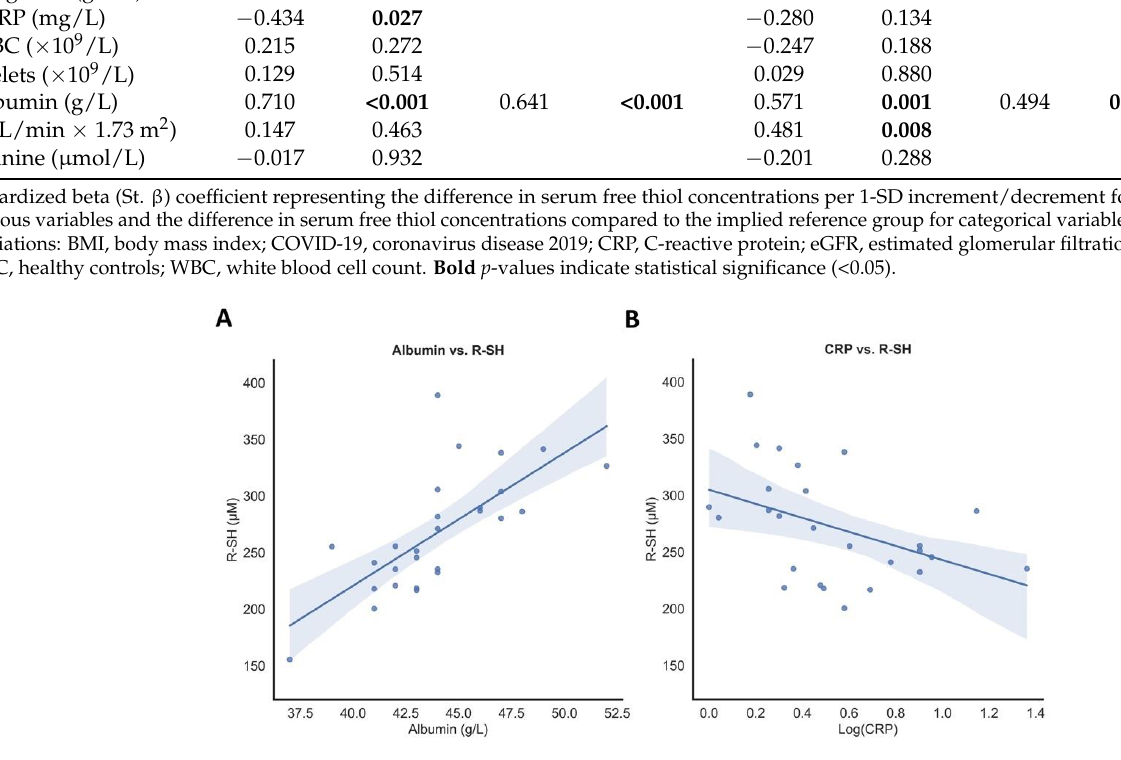
Figure 2. ( A ) Serum CRP concentrations are inversely associated with serum free thiol concentrations (R-SH) (St. β = − 0.434, p = 0.027) in mild COVID-19 subjects. ( B ) Serum albumin is positively associated with serum free thiol concentrations (R-SH) ( µ M) (St. β = 0.710, p < 0.001) in mild COVID-19